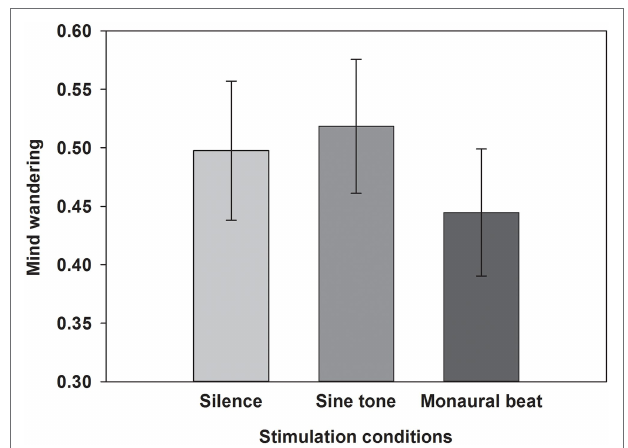
FIGURE 5 | Propensity to mind wander in subgroup with high MW questionnaire scores. The average propensity to mind wander shown across subjects in a subgroup with high MW questionnaire scores ( ≥ 19) for the three stimulation conditions. Mean and SEM are